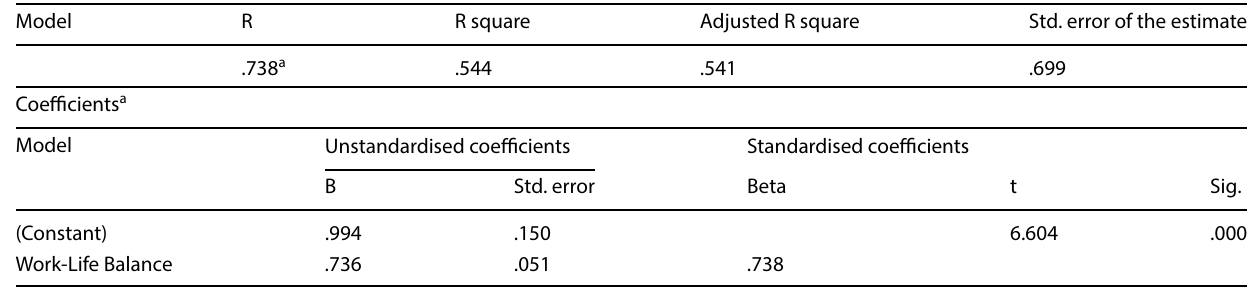
Table 6 Model summary